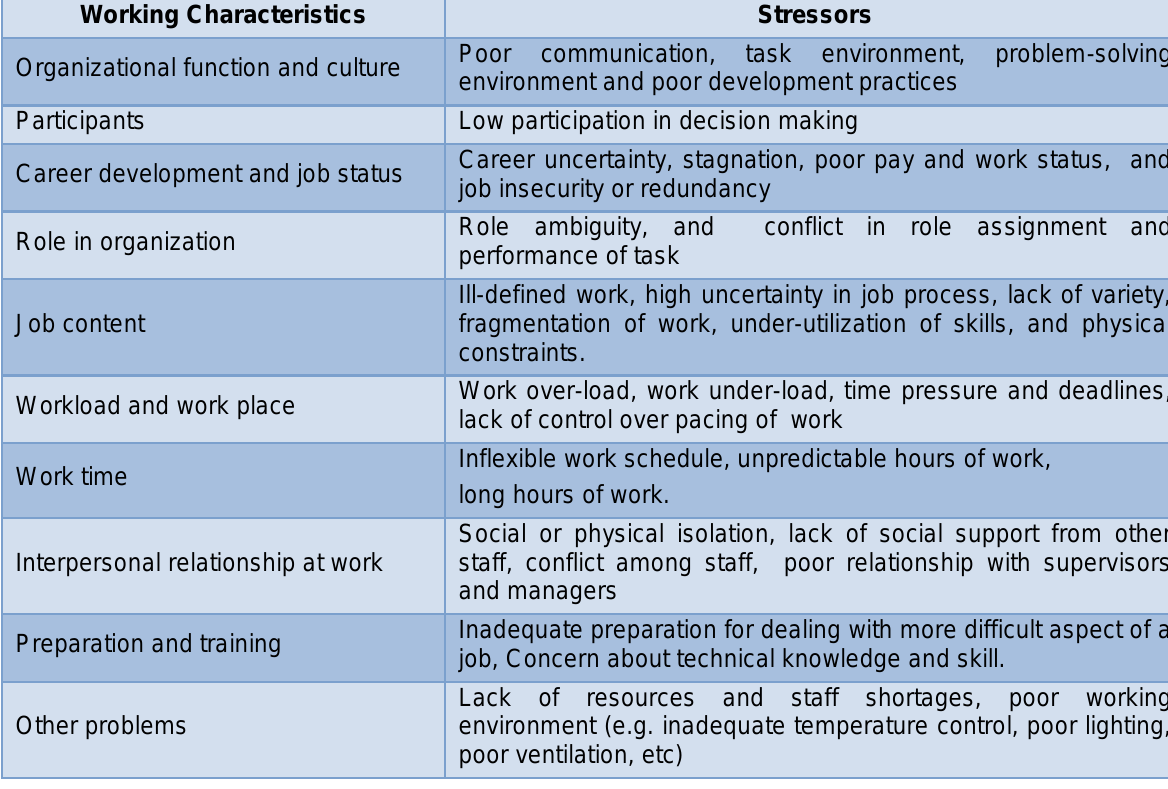
Table 1 Checklist of work characteristics and stressors Complied by the authors from different sources including Sutherland and Davidson (1989); Ng et al. (2005); Wahab